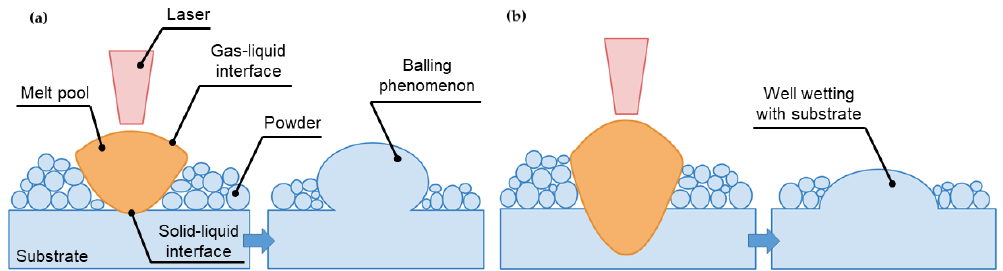
Figure 9. The solidification phenomenon during SLM: ( a ) partially penetration of laser into powder bed, ( b ) adequate laser penetration into powder